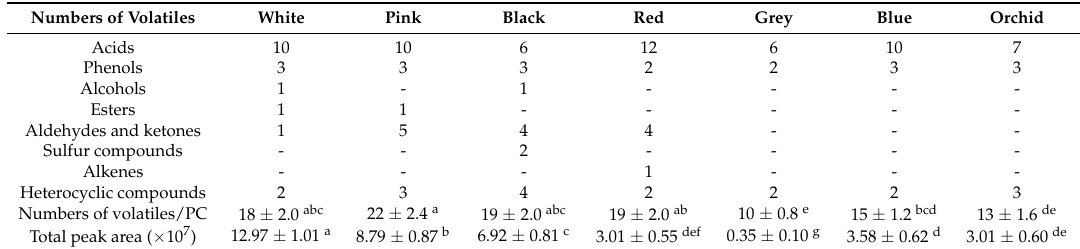
Table 1. Results of the volatile components from seven kinds of SPME